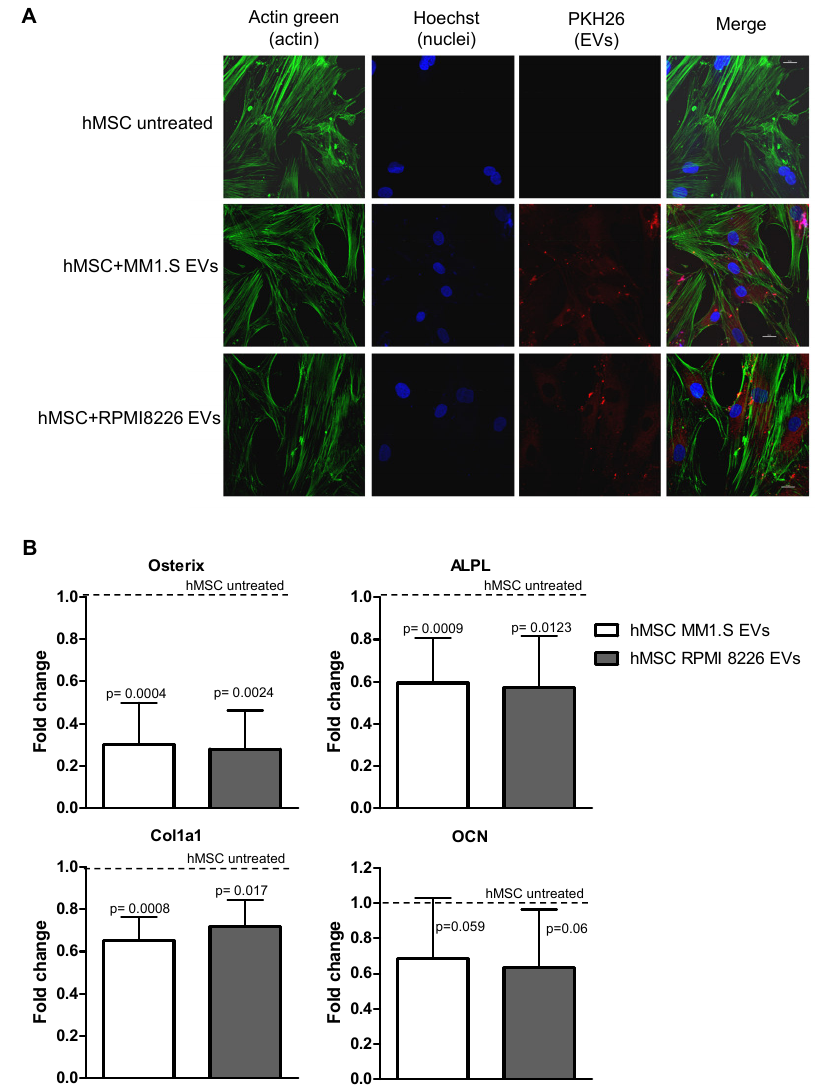
Figure 1. ( A ) Cellular internalization of MM1.S and RPMI 8226-derived EVs into hMSCs was analyzed by confocal microscopy. HMSCs were incubated for 4 h with MM-EVs labeled with PKH26 (red). HMSCs were stained with ActinGreen (green), nuclear counterstaining was performed using Hoescht (blue). Samples were analyzed at the confocal microscope (scale bar = 20 µ m). ( B ) The Real-Time PCR analyses of Osterix, ALPL, Col1A1 and OCN were performed on hMSCs maintained in the osteogenic medium after 10 days of treatment with MM1.S and RMPI 8226-derived EVs. Data were normalized for β -actin and values are expressed as Fold Change in gene expression that occurred in cells treated with EVs versus untreated hMSCs (dotted line). The statistical significance of the differences was analyzed using a two-tailed Student’s t